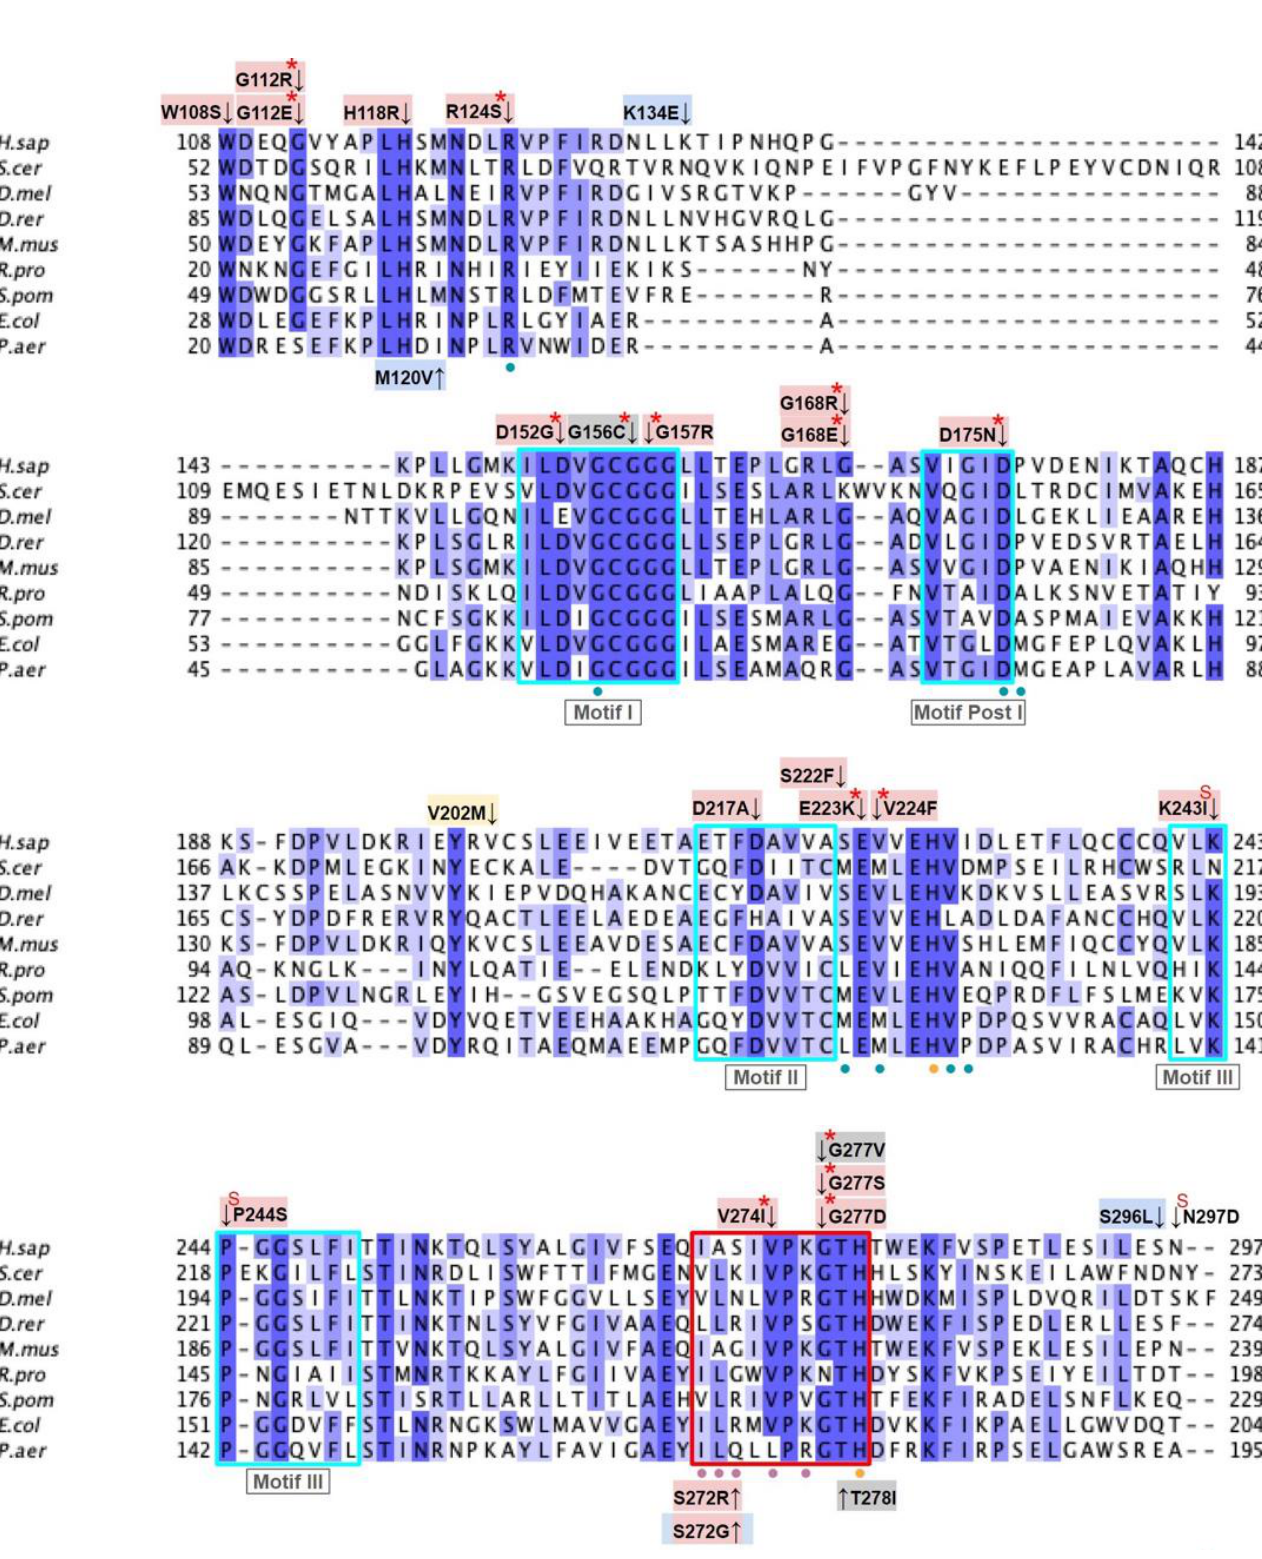
Figure 3. Labeled and annotated multiple sequence alignment of COQ3. Amino acid sequences of COQ3 were analyzed as described in Materials and Methods and include Homo sapiens (NCBI ac- cession number NP_059117.3) and homologs in Saccharomyces cerevisiae (NP_014545), Drosophila mel- anogaster (NP_610092.2), Danio rerio (NP_001002620.1), Mus musculus (NP_766275.1), Rickettsia prowazekii